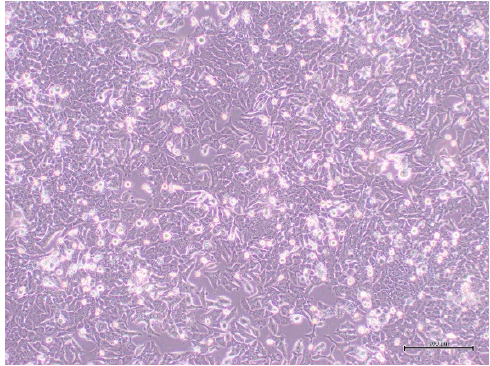
Figure 1. MCF-7 cells imaged under an inverted microscope, scale bars = 200 μ